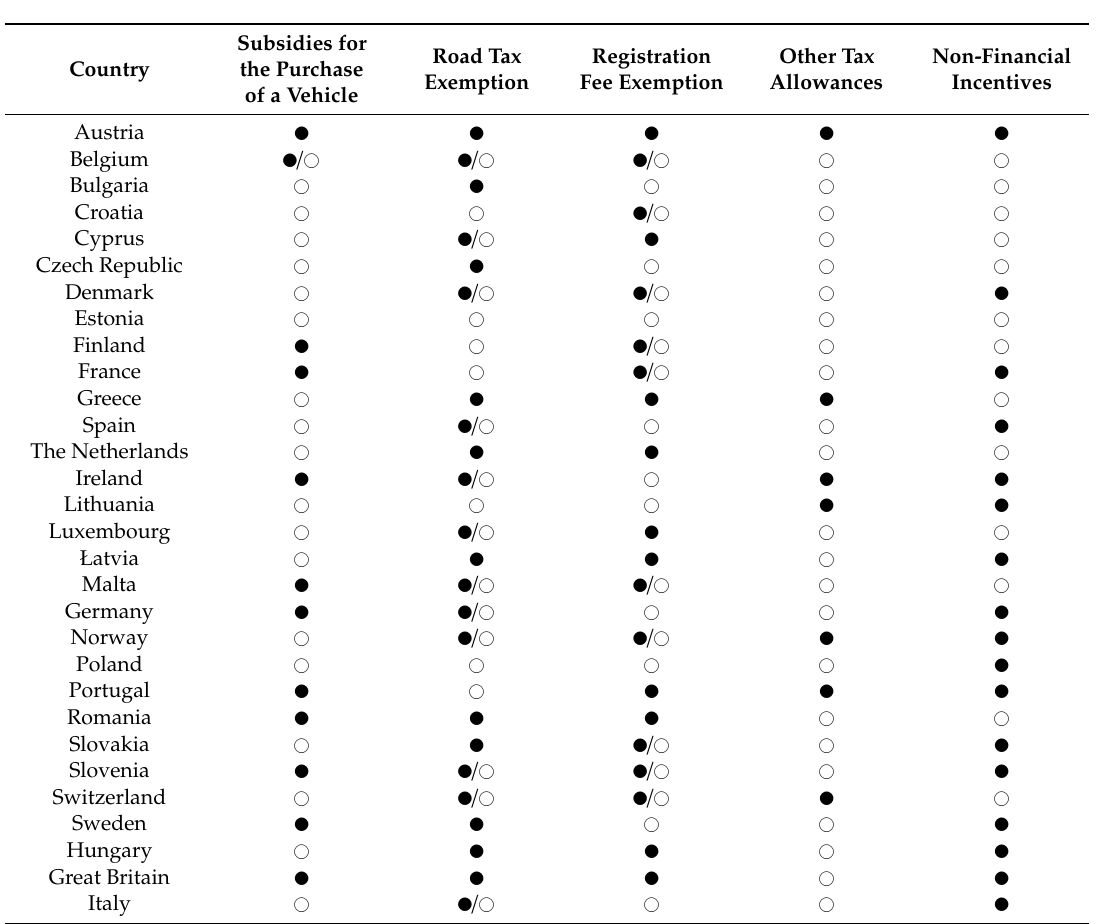
Table 2. The incentives o ff ered for purchasing and using electric cars in the European Union, Norway and